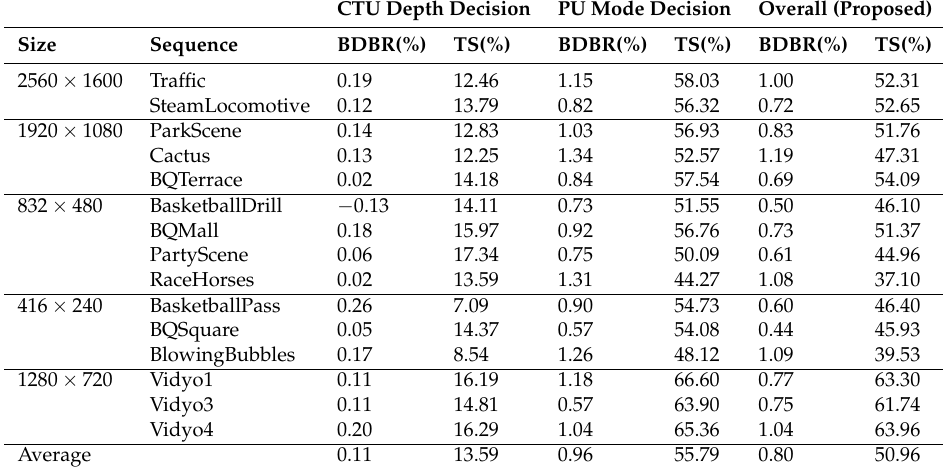
Table 3. Performance comparison of different parts of the proposed method (random access